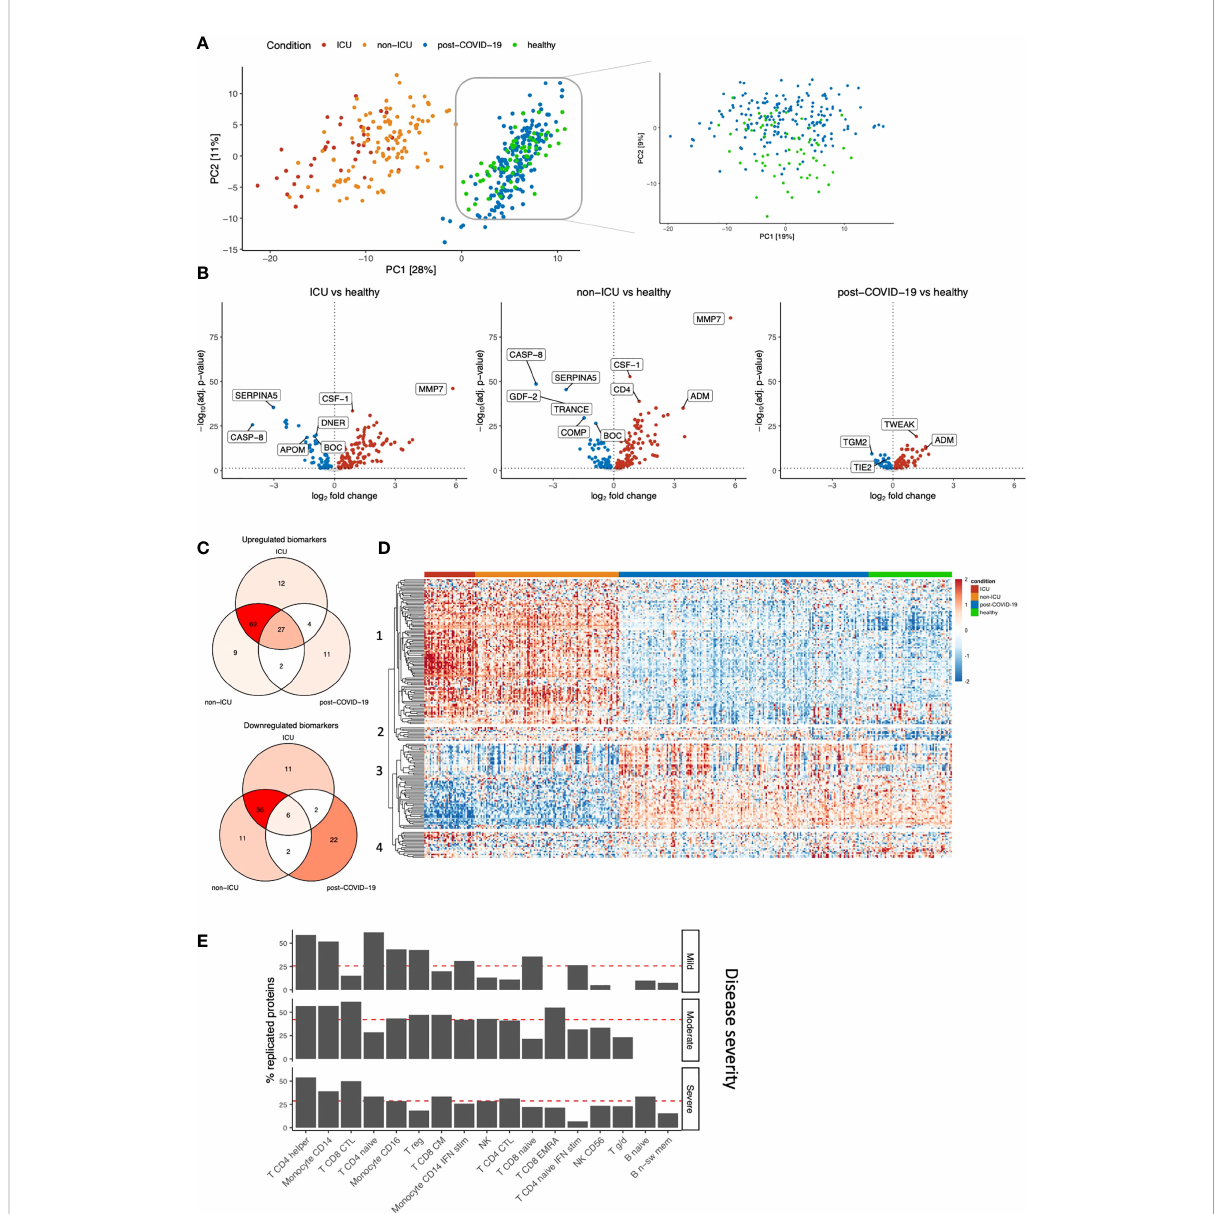
FIGURE 2 Identi fi cation of biomarkers for COVID-19 severity and post-COVID-19. (A) PCA on the protein concentrations of COVID-19 hospitalized patients, post-COVID-19 individuals, and healthy individuals (left). We performed PCA-based dimensionality reduction on cohort 3 separately to highlight the differences between healthy and post-COVID-19 individuals (right). (B) Signi fi cantly different proteins in ICU, non-ICU and post- COVID-19 individuals compared to healthy individuals. Upregulation (red) indicates higher protein concentrations compared to healthy individuals, whereas downregulation (blue) indicates lower proteins concentrations compared to healthy individuals. Proteins that do not signi fi cantly differ are shown in grey. The vertical dotted line indicates log-fold change 0. The horizontal dotted line demonstrates signi fi cance at the adjusted p-value level. For ICU and non-ICU patients, only the fi rst time-point per patient was considered. (C) Shared and exclusive signi fi cantly abundant proteins between the conditions, compared to healthy individuals. Venn diagrams are colored with respect to the number of proteins. (D) Heatmap of the signi fi cantly differentially abundant proteins. Each row represents a protein that is signi fi cantly different in any of the conditions: ICU, non-ICU or post-COVID-19 individuals compared to healthy. Columns represent patients, and the column annotations indicate the condition of each patient. For ICU and non-ICU patients, only the fi rst time point was considered. (E) Barplot showing replication of the post-COVID-19 proteome signature in publicly available single-cell RNA sequencing data. We replicated the post-COVID-19 signature in post-COVID-19 patients who experienced three different COVID-19 severities: Mild, Moderate or Severe. Proteins were considered replicated when the corresponding gene was nominally signi fi cant compared to healthy individuals and directionally concordant with the proteome. Red lines indicate the average replication rate calculated over these cell types. Only the most abundant cell types are